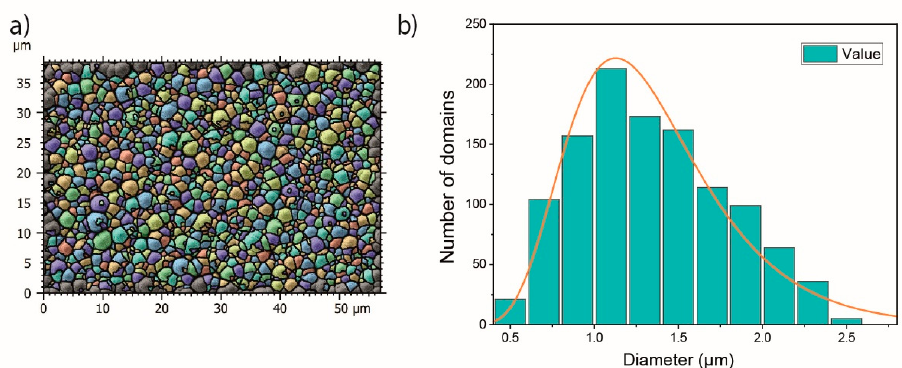
Figure 4. ( a ) Size of the multilayer domain structure in top-view, analyzed by a watershed filter in MountainsMap software [22], used to obtain the domain size log-normal distribution shown in ( b ). Figure 3(b.1,b.2) reveals a change of the curvature of the deposited layer due to the